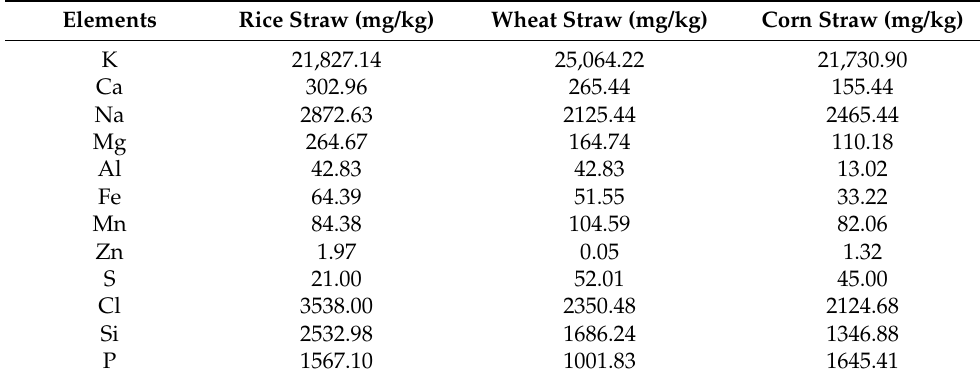
Table 2. Results of the minor element analysis of the three crop